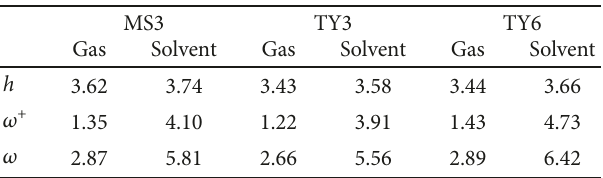
Table 5: Chemical reactivity parameters (in eV) of MS3, TY3, and TY6 in gas and solvent, respectively.